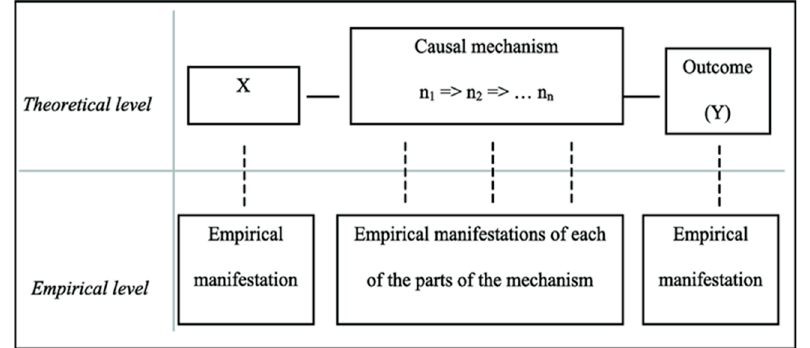
Figure 2. Elements of the causal process tracing method